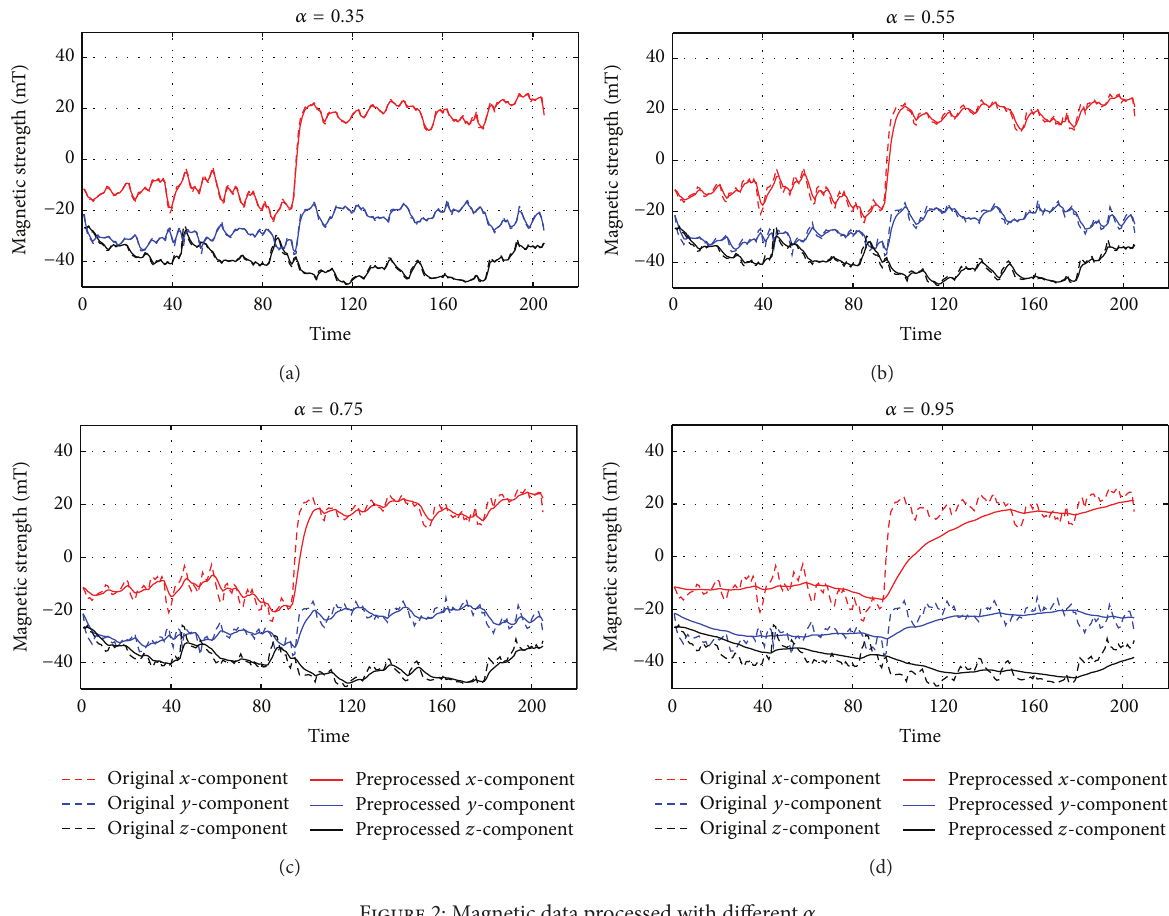
Figure 2: Magnetic data processed with different 𝛼